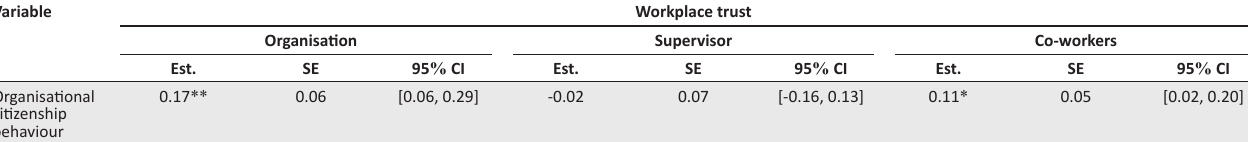
TABLE 7: Indirect effects of authentic